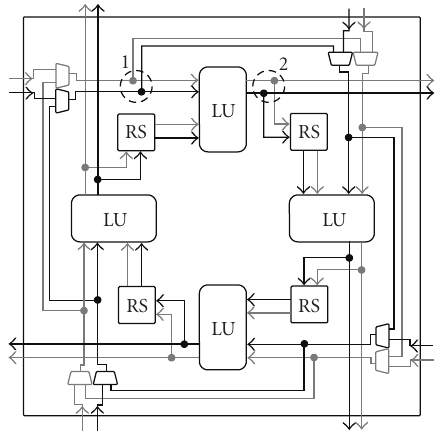
Figure 4: Adding selectors for making right turns. The numbered circles locate forks.